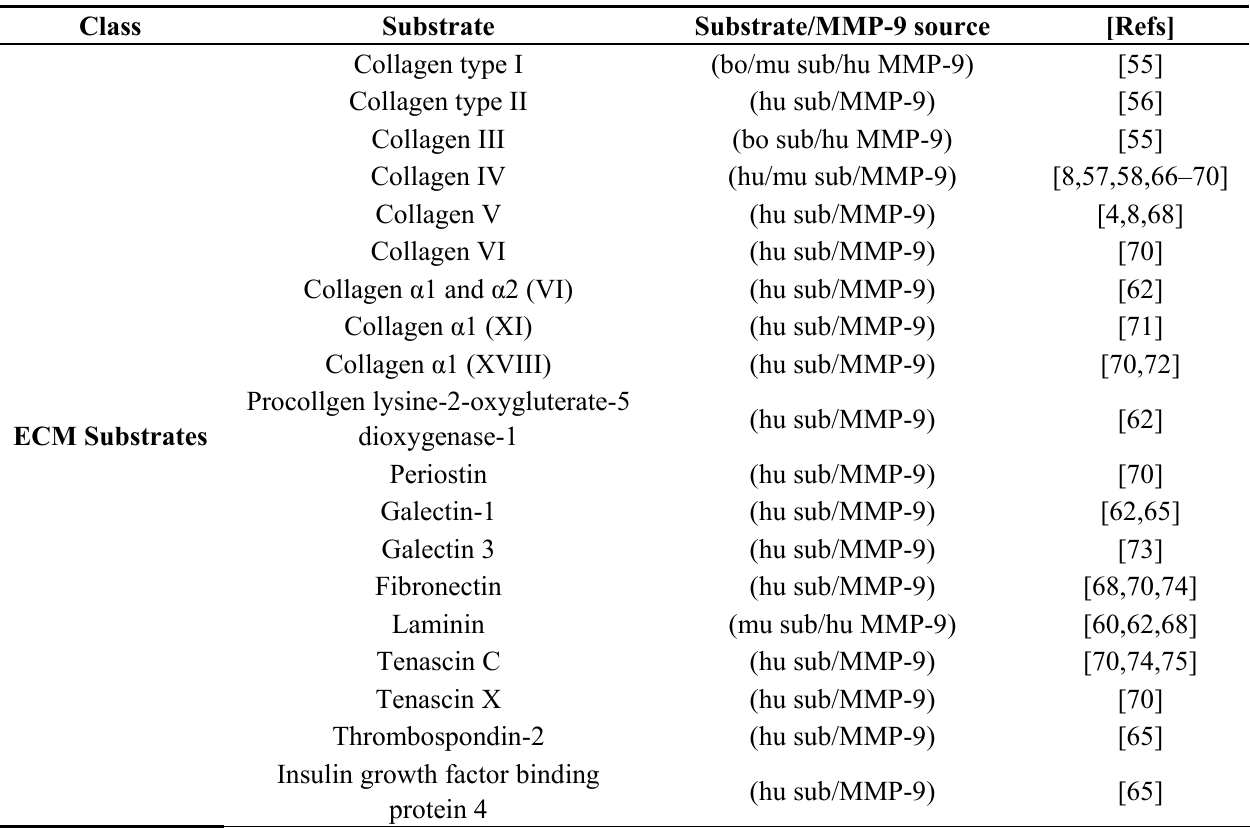
Table 1. Update of Gelatinase B/MMP-9 substrates. Substrates (sub) and MMP-9 origins are provided: human (hu), mouse (mu), bovine (bo) and rabbit